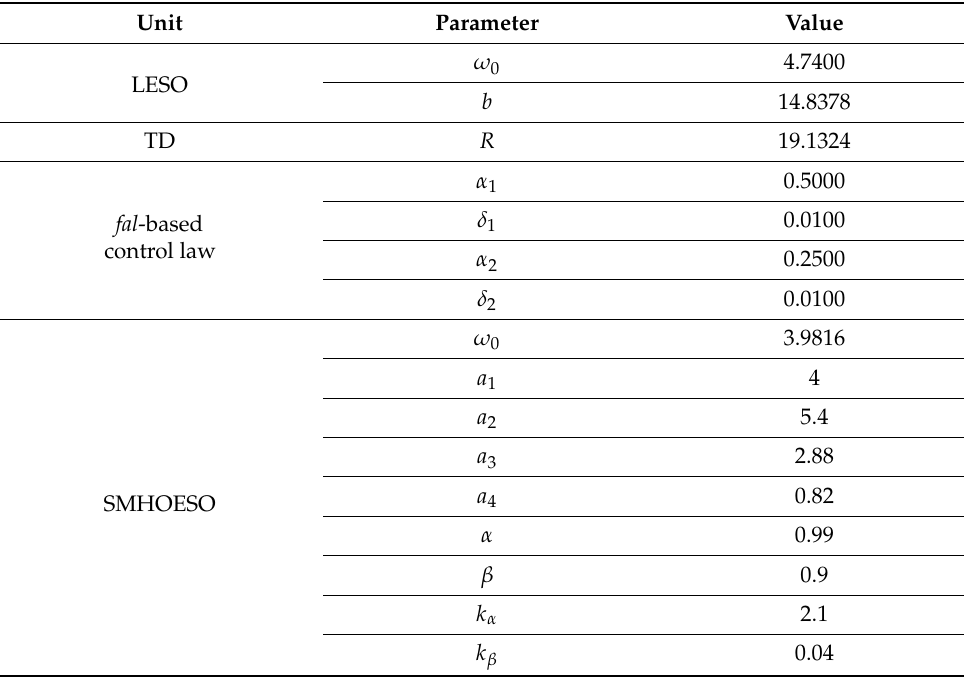
Figure 5. The Differential drive mobile robot. Figure 5. The Di ff erential drive mobile robot. Table 3. Parameters of the ADRC units.